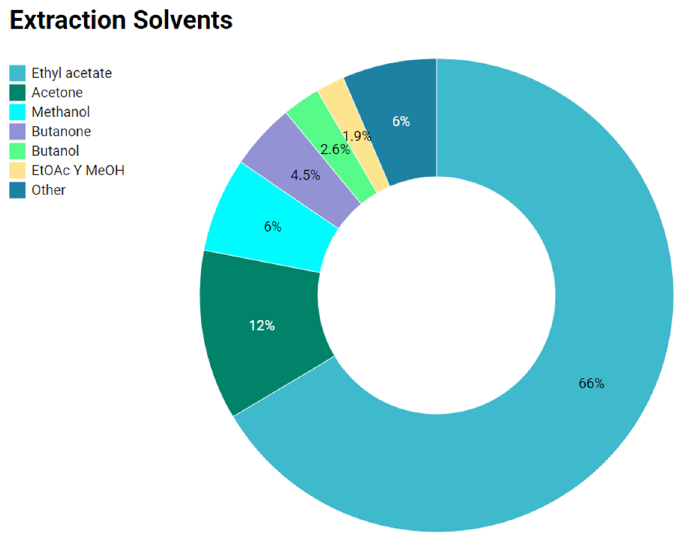
Figure 4. Organic solvents used to obtain actinobacterial extracts and compounds. EtOAc—MeOH: Ethyl acetate—Methanol.